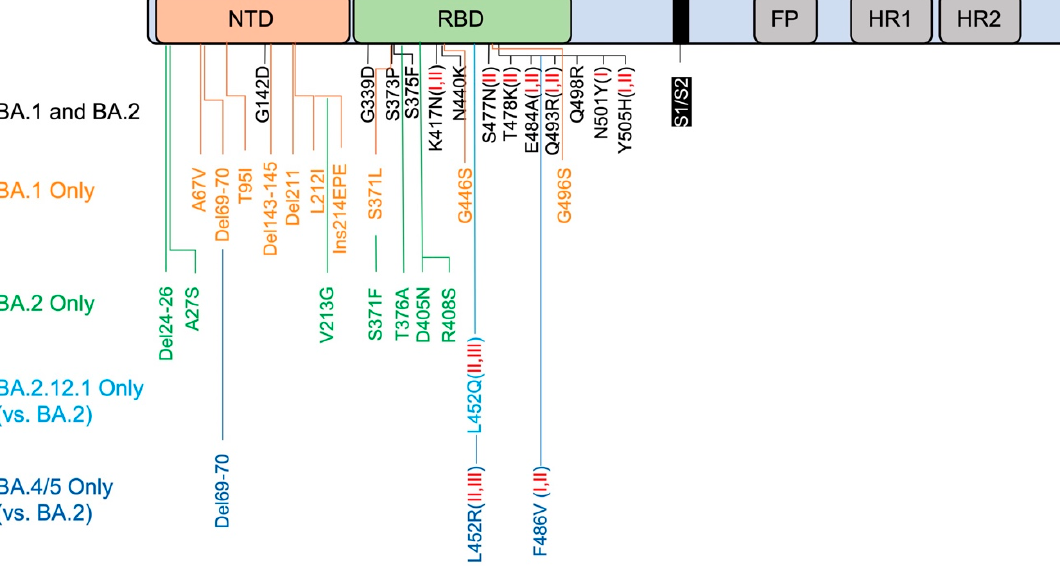
Figure 1. Spike mutations that contribute to immune evasion. Schematic representation of spike (not to scale) contains NTD (N-terminal domain), RBD (receptor-binding domain), S1/S2 cleavage site, FP (fusion peptide), HR1 (Heptad repeat) and HR2. Del: Deletion, Ins: Insertion. Red I and/or II in brackets indicate clearly described class I and/or II antibodies that have been dampened by the particular mutation.